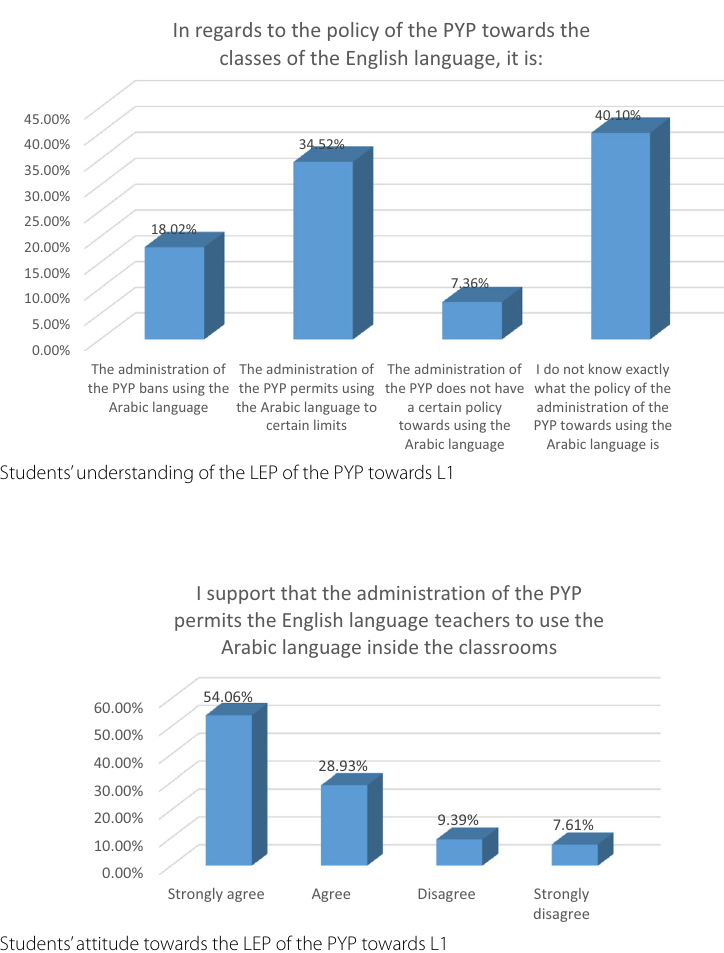
Fig. 5 Students’ attitude towards the LEP of the PYP towards